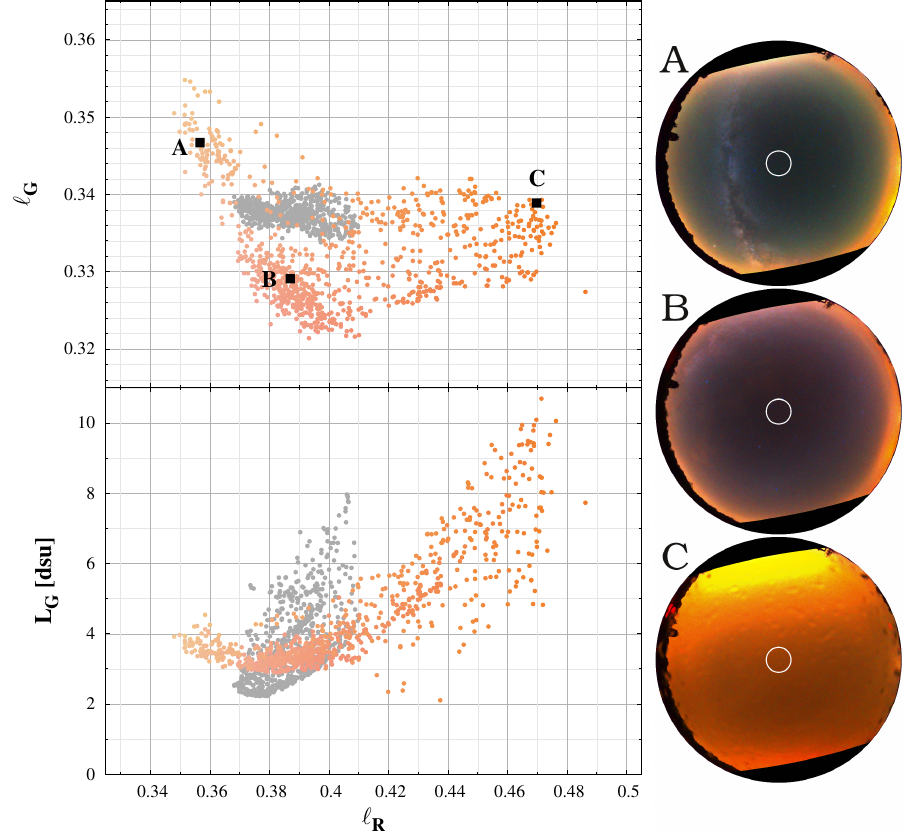
Figure 5. Left: Colour–colour ( top ) and colour–radiance ( bottom ) diagram calculated from the all sky images taken in the Zselic Starry Sky Park at a fixed measurement station. The colours of the symbols represent the real colour of the sky. The grey dots display for comparison the darkest night from a simple image. Right: Three typical all sky images from the permanent camera in Zselic. The white circle indicates the part of the sky used for the analysis. The corresponding colour pairs are indicated by the letters ( A – C